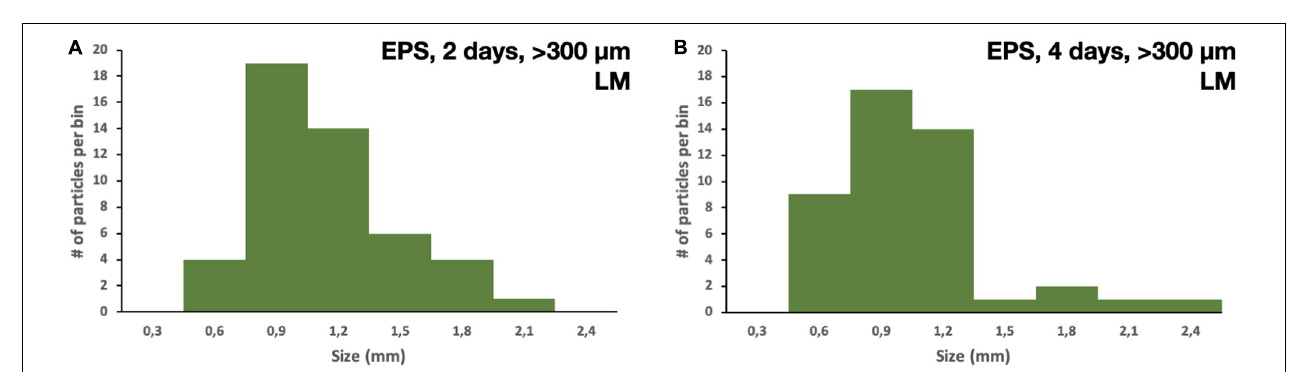
FIGURE 3 | Size distribution of particles collected on the 300 µ m filter after (A) 2 days of fragmentation and (B) 4 days of fragmentation.